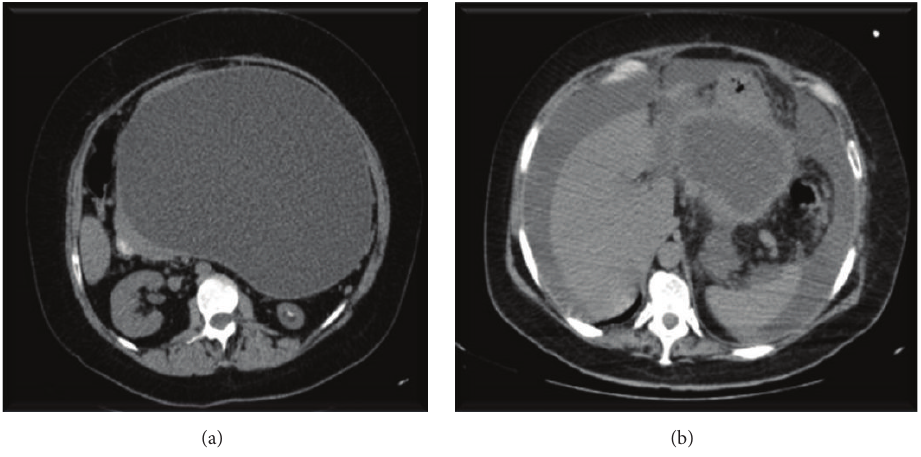
Figure 1: CT scan before and after pseudocyst rupture.